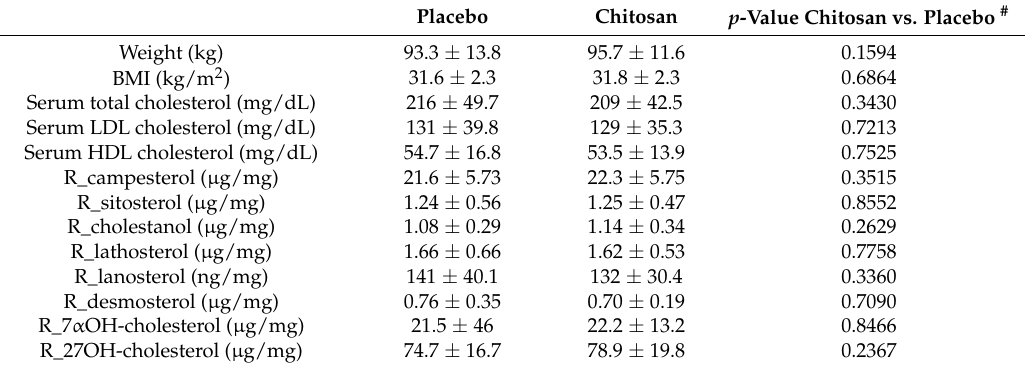
Table 1. Comparison of baseline data (mean ± SD) of the chitosan group and placebo group. Placebo